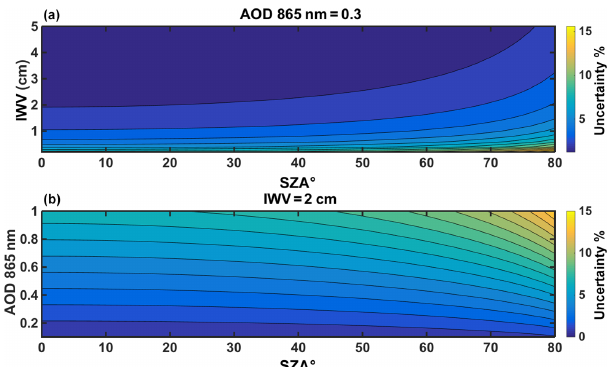
Figure 8. Uncertainty (%) of IWV retrieved using the monochro- matic approach at 946nm for various solar zenith angles ( ◦ ) with respect to AOD (when IWV = 2cm) in the upper plot and IWV (when AOD = 0.3) in the lower plot.